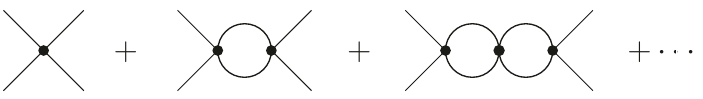
Figure 1 . Two-body amplitude in the non-relativistic theory. The filled dots denote the full four-particle vertex that can be read off from the interaction Lagrangian. This vertex is a low-energy